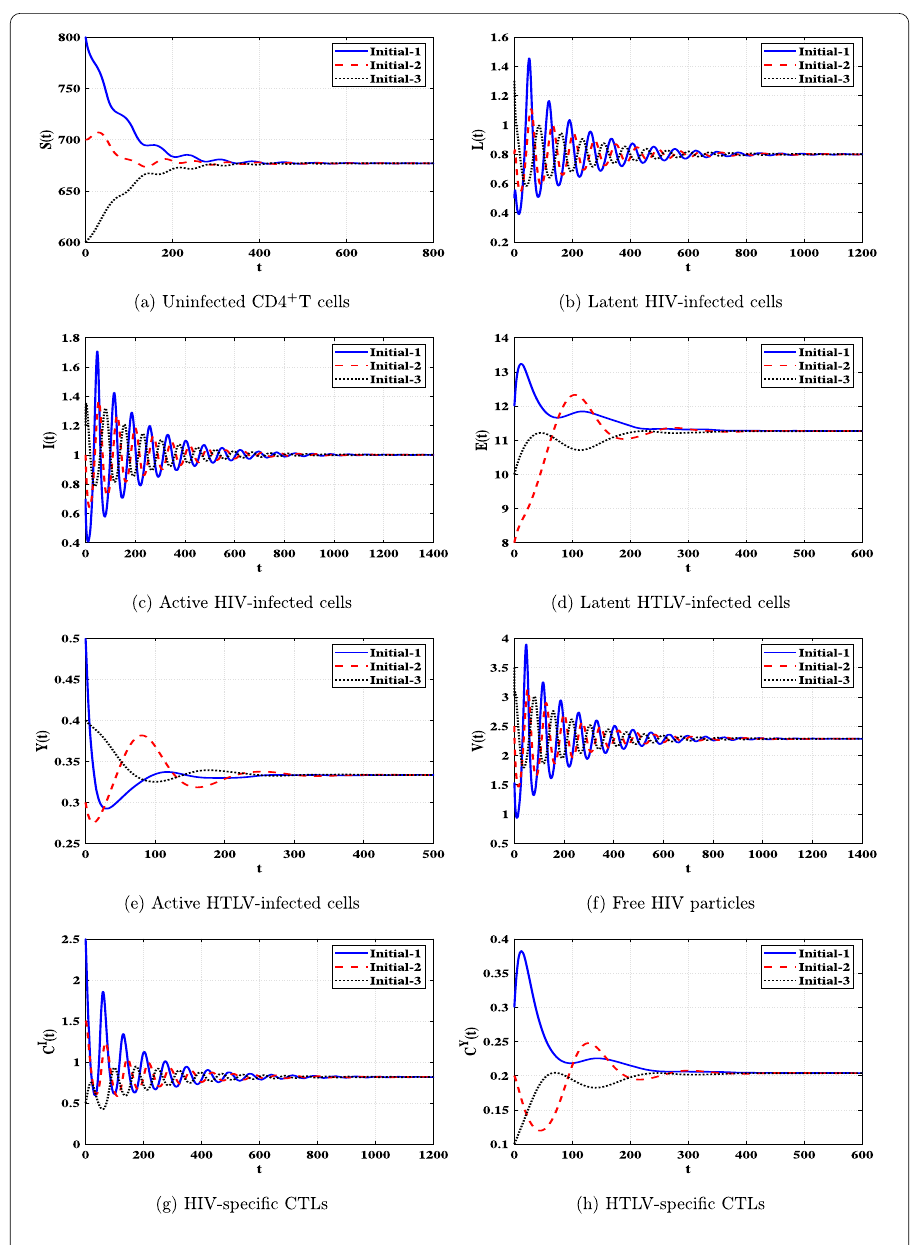
Figure 8 Solutions of system (29) when (cid:9) 7 > 1 and (cid:9) 8 >